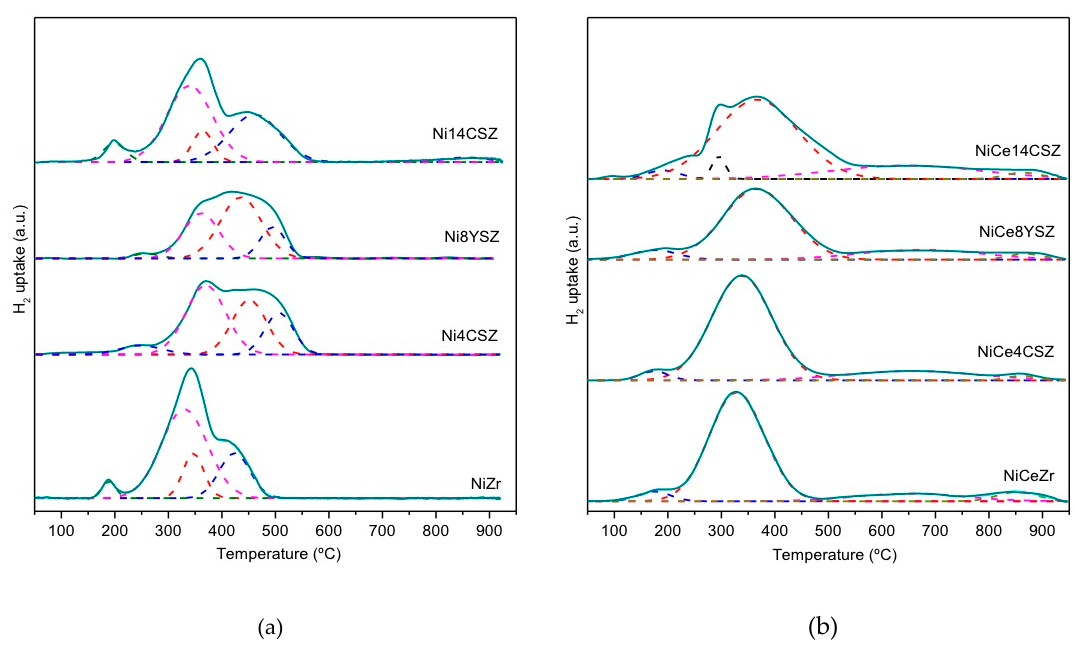
Figure 3. H 2 -TPR profiles: ( a ) samples without Ce; ( b ) samples with Ce.